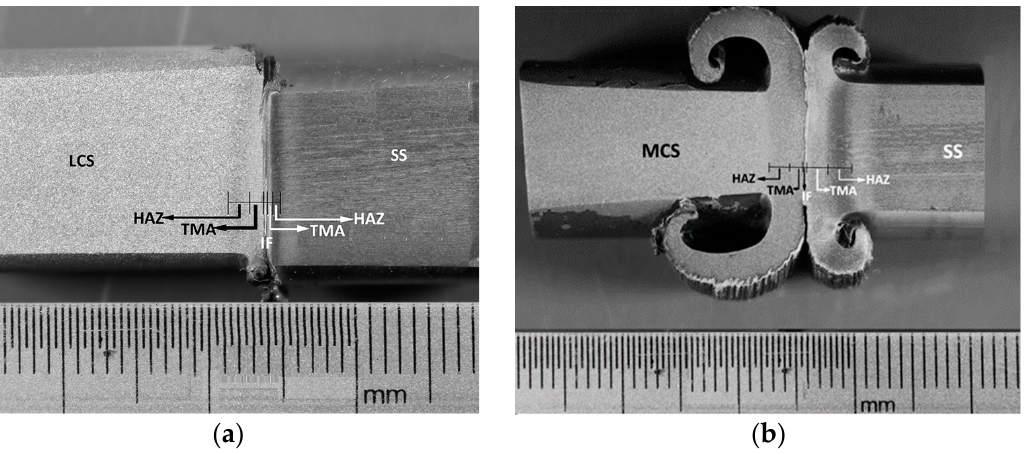
Figure 4. Macrostructures at the joints of ( a ) low-carbon steel–304 SS ( P f = 16, T f = 4, and P u = 40) and ( b ) medium-carbon steel–304 SS ( P f = 90, T f = 7, and P u = 95). Heat was generated during the application of friction pressure due to the friction of the mating surfaces. The applied pressure caused heavy deformation in both metals at the same time. The microstructural change was caused by a temperature increase and heavy deformation. Deformation, dynamic recovery, and recrystallization occurred, stimulating microstructural change around the joint. Aside from structural changes, the different element concentrations in the metals may cause element diffusion. As a result, elemental irregularities and the formation of new phases around the joint were also